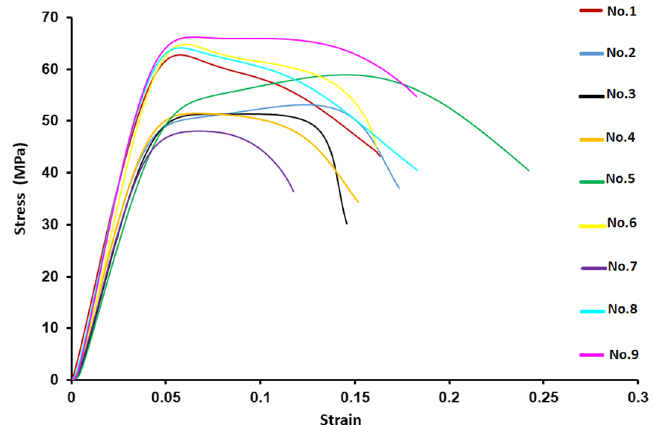
Figure 5. Stress–strain curves of all